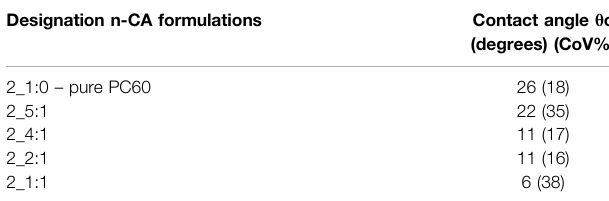
TABLE 8 | Contact angle results for varying n-CA formulations.